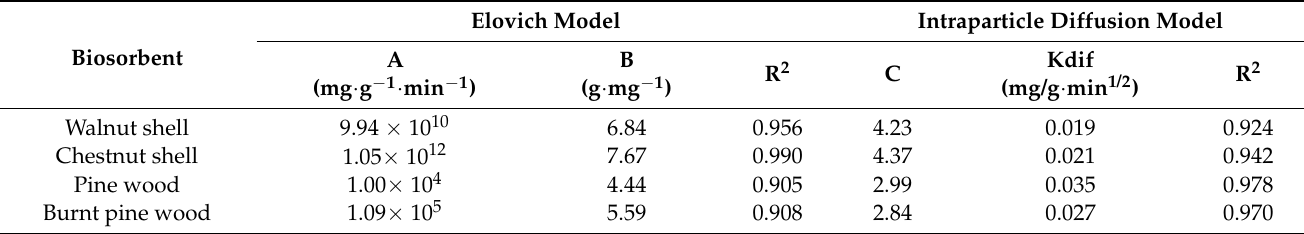
Table 4. Parameters for the kinetic data using Elovich and intraparticle diffusion